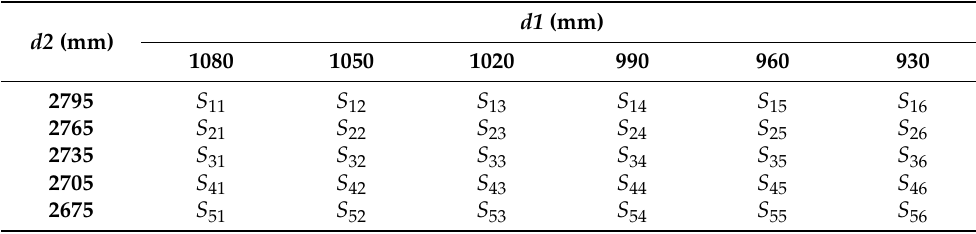
Table 2. Definition of stress distribution curve at weld 1 in each model. (mm)